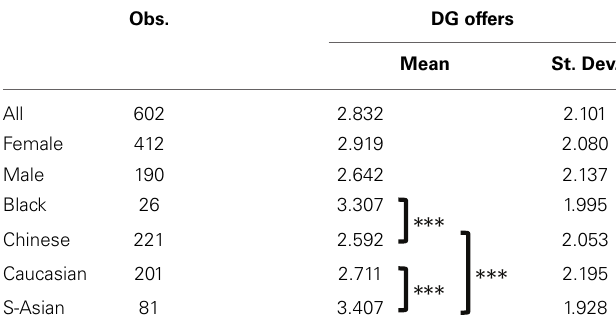
Table 3 | Summary statistics for individual giving in the Dictator